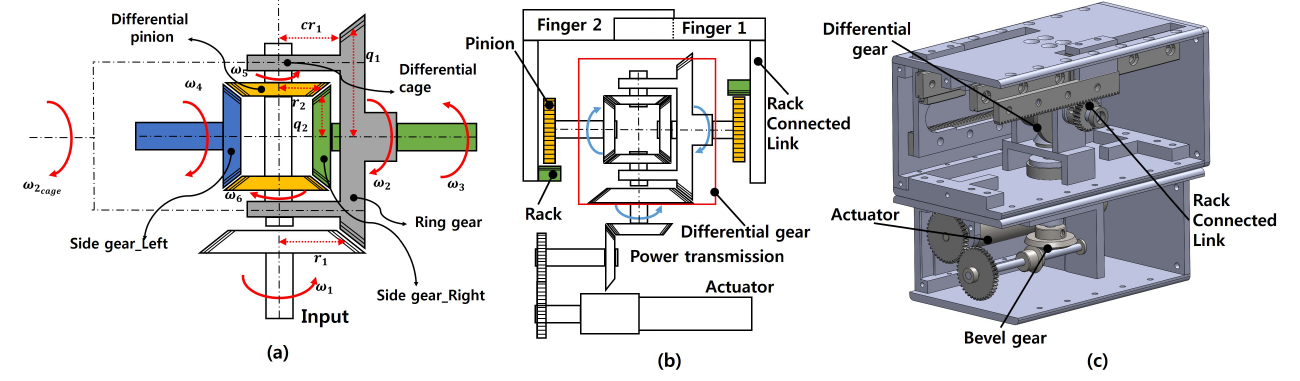
Figure 2. Structure of the actuator using a differential gear mechanism. ( a ) Structure of differential gear. ( b ) Schematic of whole driving mechanism. ( c ) Realization of